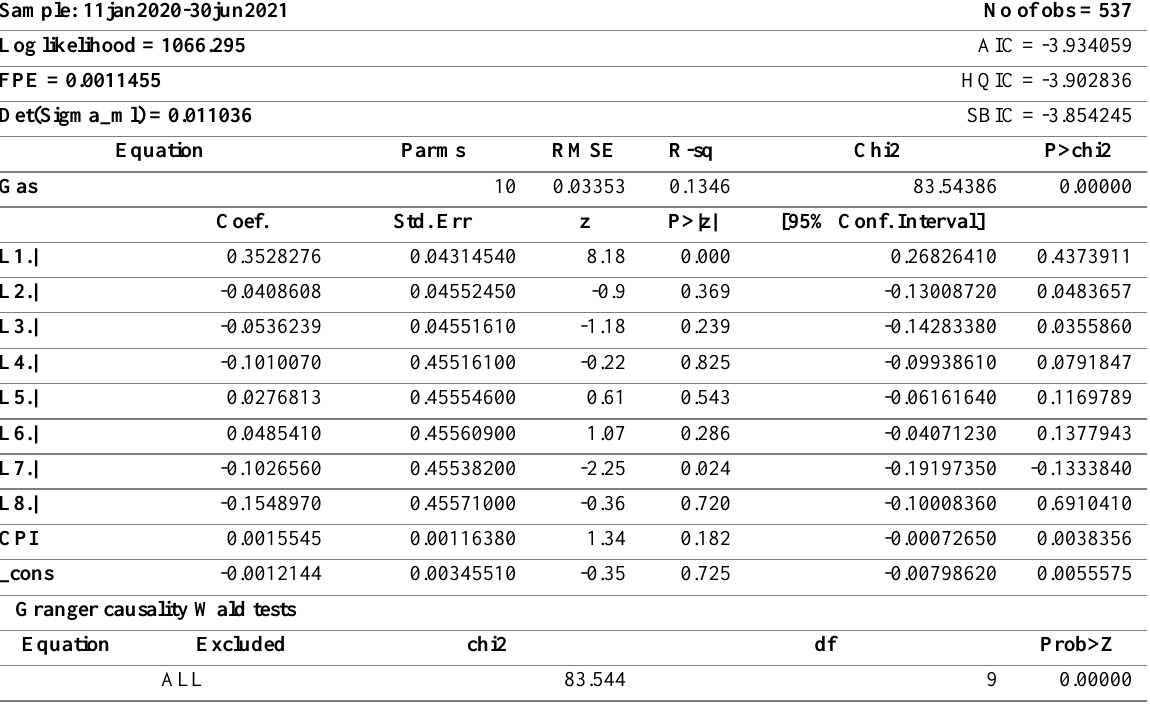
Table 5: VAR and Granger causality wald test results for CPI and natural gas